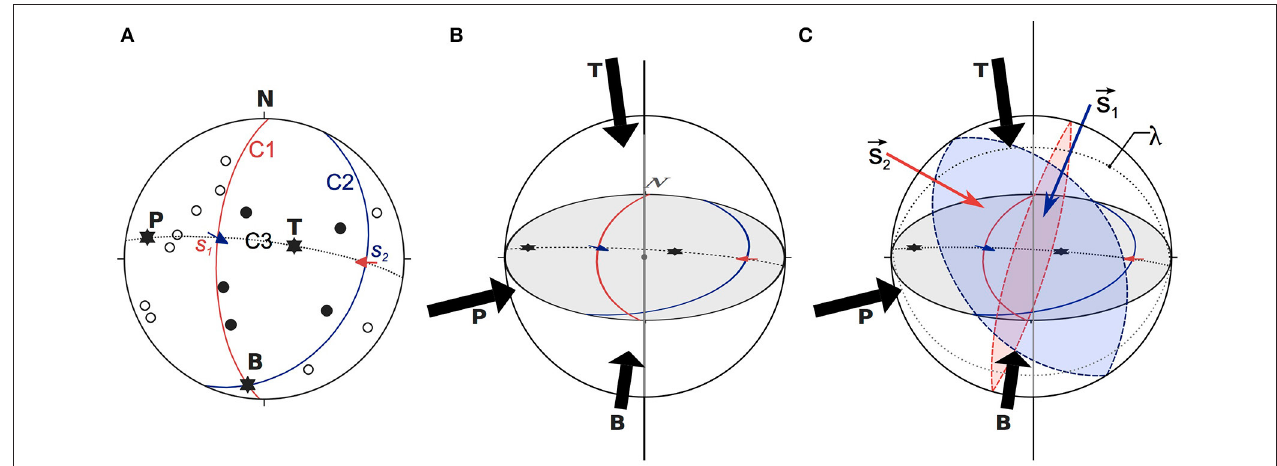
FIGURE 1 | The Byerly’s Fault Plane Solution. (A) A FPS is a stereographic projection representing the double-couple model of the seismogenic source; equal-area stereographic projection technique (lower hemisphere), void circles are P-wave downward first arrivals, solid circles are P-wave upward first arrivals, C 1 and C 2 are nodal planes with associated slip vectors s 1 (pole to C 2 ) and s 2 (pole to C 1 ), P- (compressive) T- (tensional) and B-axes (neutral) are also plotted; (B) Three-dimensional view of a Focal Sphere, the FPS of (A) represents the stereographic projection (on the equatorial plane) of the geometrical elements intersecting the lower hemisphere. (C) 3-D perspective of the FPS (see text for